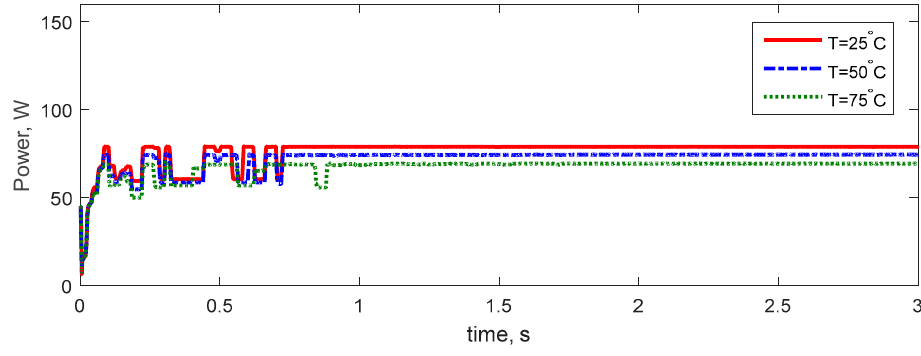
Figure 17. PV power in pattern 4 considering temperature changes using the ROA.